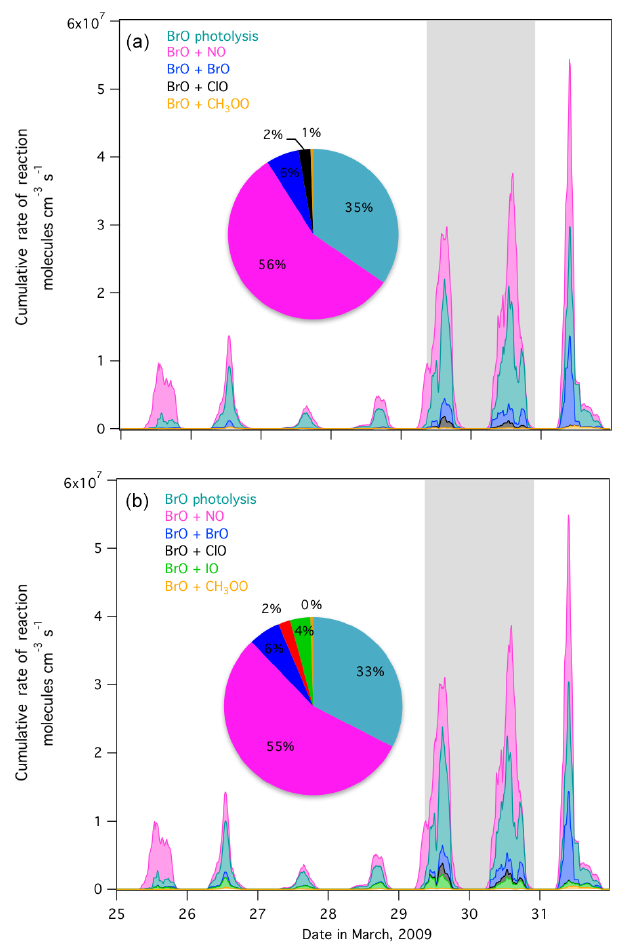
Figure 7. Time-varying rates of the most important bromine prop- agation reactions in the base model with Br and Cl present (a) and with iodine included (b) . The BrO + BrO reaction is calculated as 2 k [BrO] 2 as this reaction regenerates two Br atoms. Model output is smoothed by hourly averaging. The y axis is expressed as a cu- mulative rate of reaction. The grey-shaded box represents a period of missing Br 2 observations. Time is expressed in Alaska standard time. The inset pie charts show the average fractional importance of each reaction pathway for only the days of 29 and 30 March (i.e.,